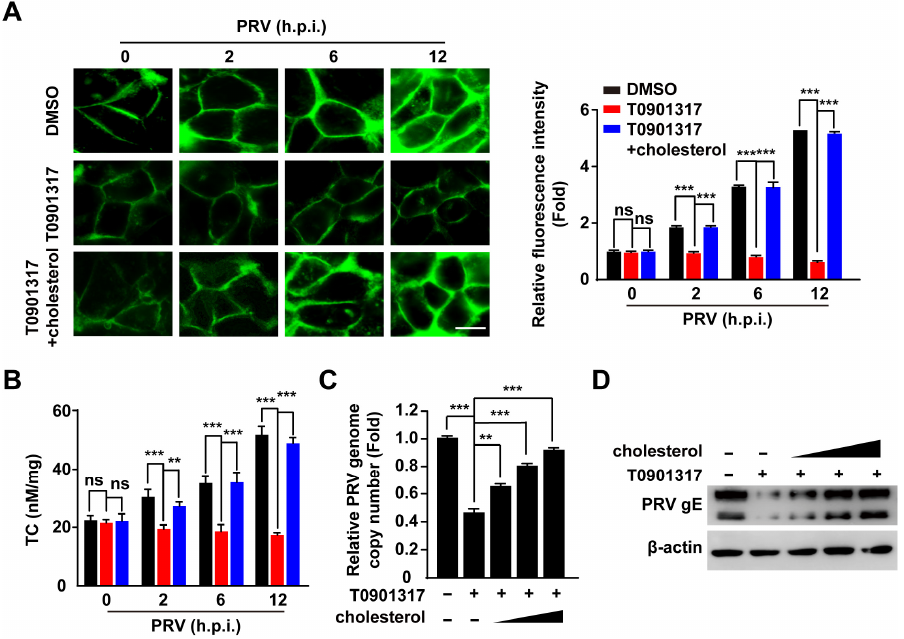
Figure 5. Activation of LXR decreases cellular cholesterol to inhibit PRV entry. ( A ) PK-15 cells were infected with PRV-QXX (MOI = 0.1) and simultaneously treated with DMSO, T0901317 (6 µ M),